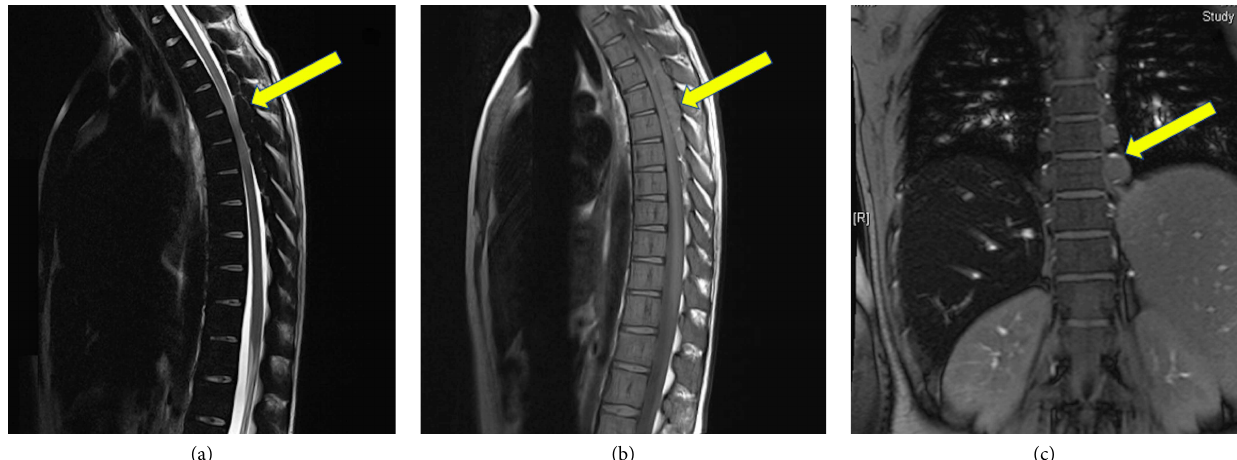
Figure 2: Follow up MRI of the spine after blood transfusion: (a) sagittal T2-weighted, (b) sagittal T1-weighted, (c) coronal T1-weighted images showing interval reduction in cord